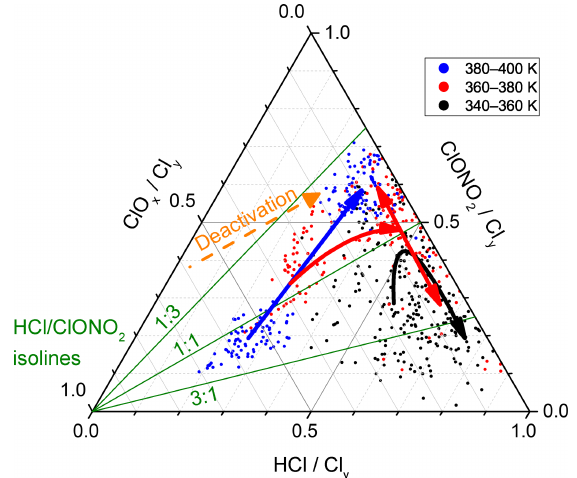
Figure 7. Ternary diagram of the partitioning of Cl y into HCl, ClONO 2 and ClO x during the second main campaign phase, from 26 February to 18 March 2016. The HCl isolines run from bottom left to top right, the ClONO 2 isolines horizontally and the ClO x iso- lines from top left to bottom right. Dots mark individual measure- ments, where colours indicate the isentropic layers. Solid arrows illustrate the temporal evolution of the daily averages. As an aid to the reader, three green lines denote characteristic values of the HCl / ClONO 2 ratio, and the orange dashed arrow points towards decreasing values of the ClO x